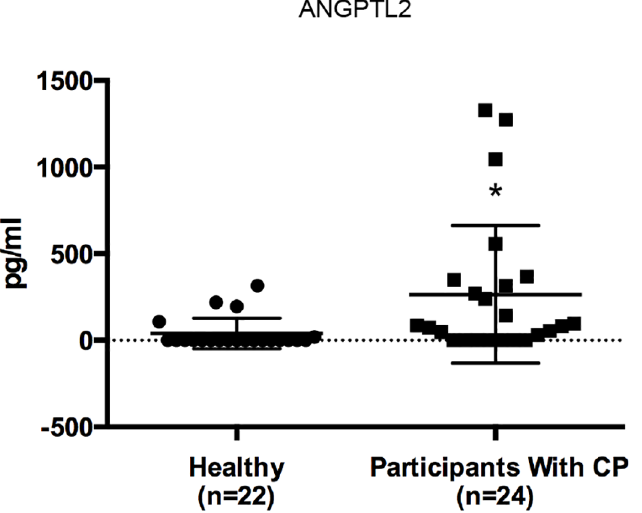
Fig 1. ANGPTL2 protein levels are increased in GCF from CP patients. ANGPTL2 protein levels were comparedin GCF from CP patients and healthyindividualsusing the Student’s t -test. Data are expressedas means ± SD. * p < 0.05 vs